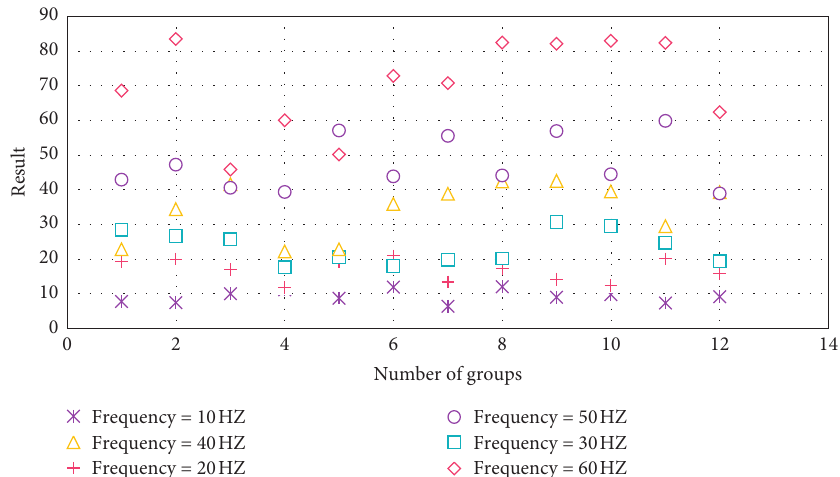
Figure 10: The original high-frequency coded signal collected by using an